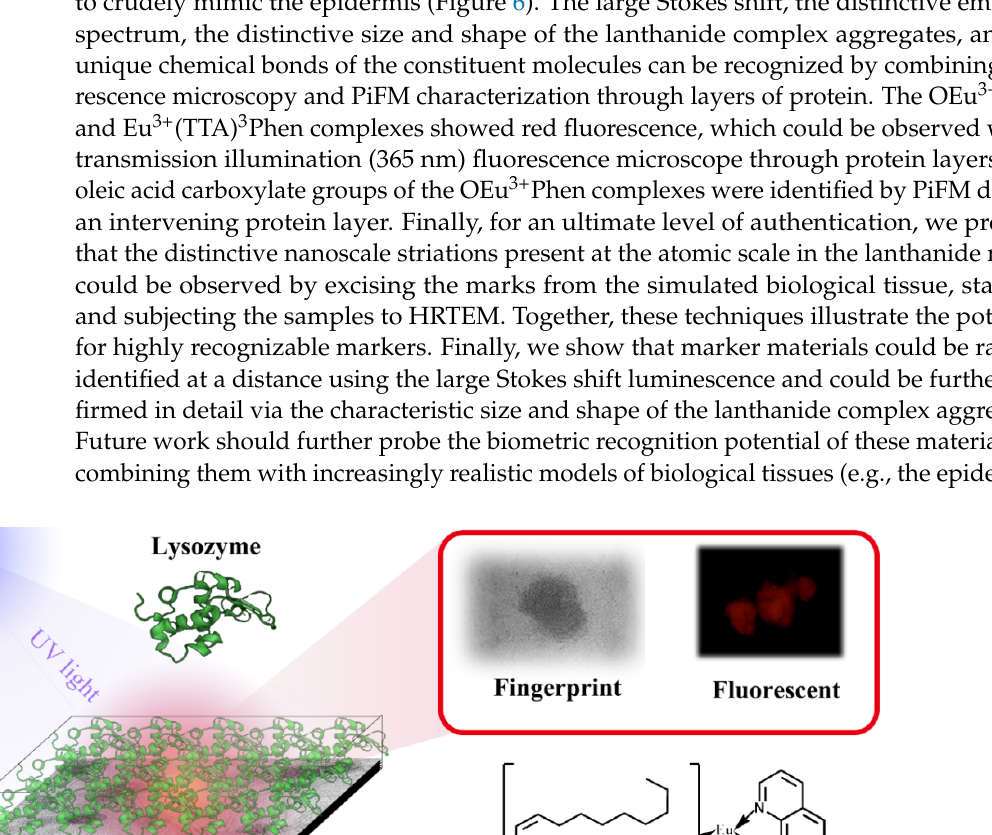
Figure 6. Principle diagram of Eu 3+ complexes implanted under protein.